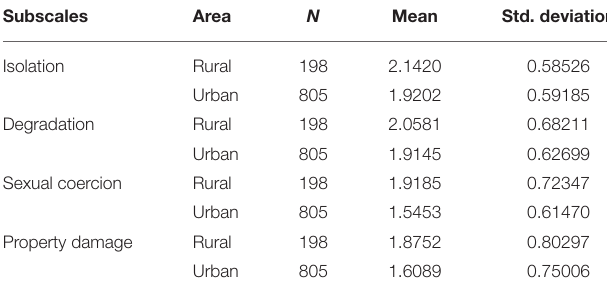
TABLE 3 | Means and Std. deviation of emotional abuse victimization by